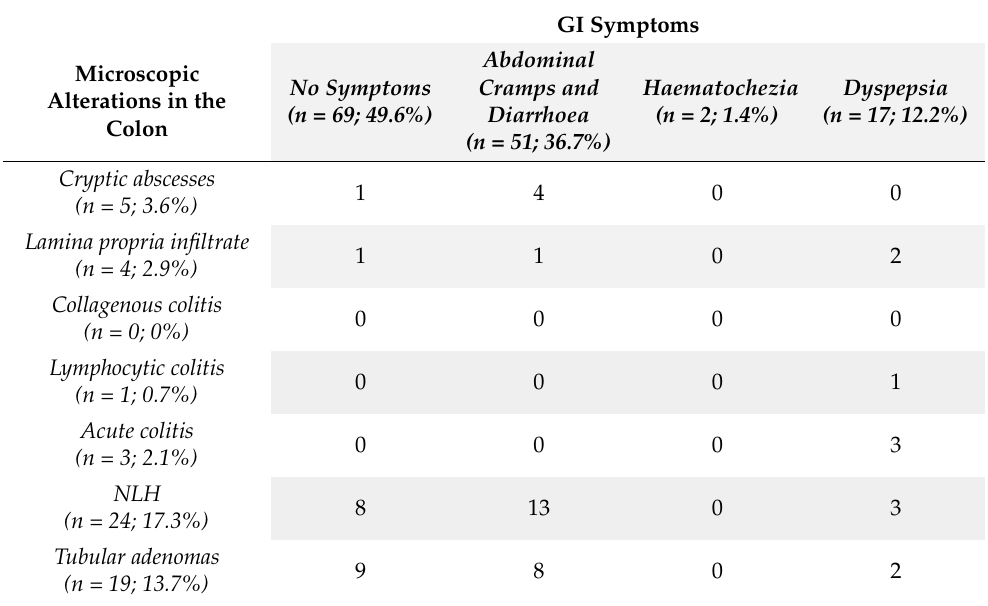
Table 5—GI = gastrointestinal; NLH= nodular lymphoid hyperplasia. Table 6. Haematological differences between NLH and non-NLH patients.